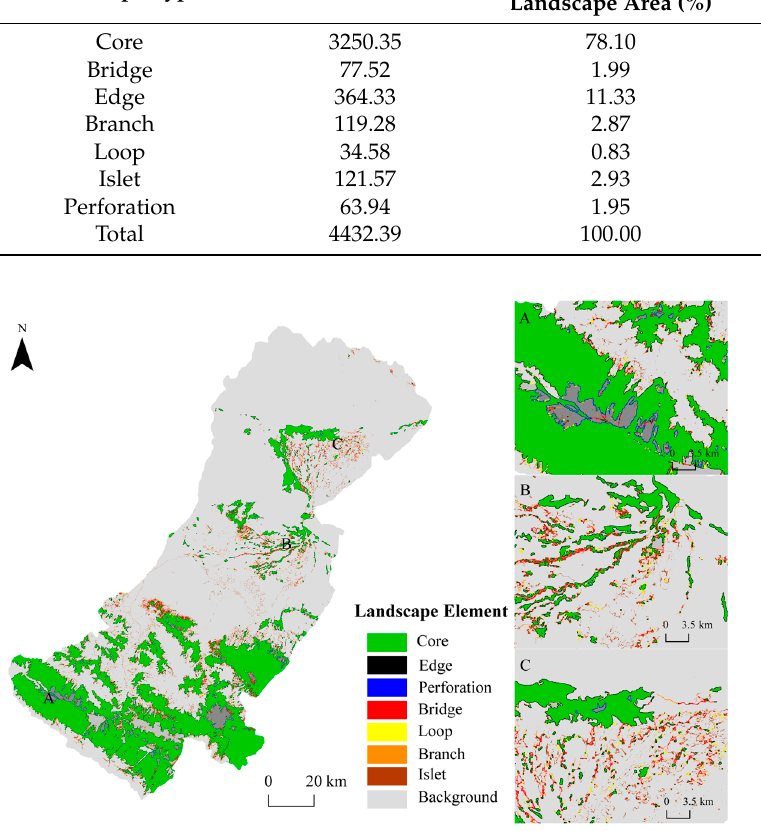
Figure 5. Landscape type map based on MSPA. Note: A, B and C are core patches:A. Qilian Mountain area patch, B. Huahai Wetland in Xincheng town in the east and lower reaches of Jiayuguan City and the agricultural areas in Suzhou District of Jiuquan City, and C. Beihai Wetland in Jinta County, Jiefangcun Reservoir, and Yuanyangchi Reservoir in Suzhou District of Jiuquan City.